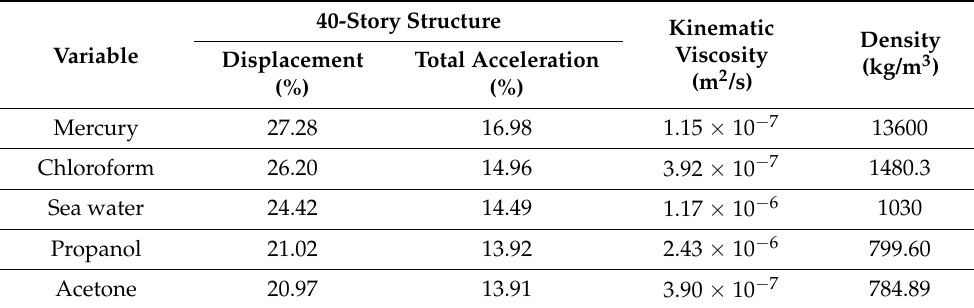
Table 13. Structure displacement and total acceleration reduction percentages with TLD for the 40-story